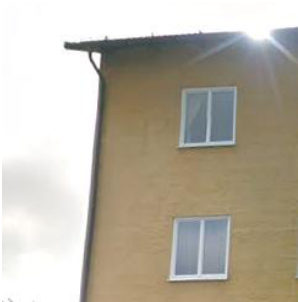
Table 4. Building characteristics that were observed in Google Street View and their respective measurement type.